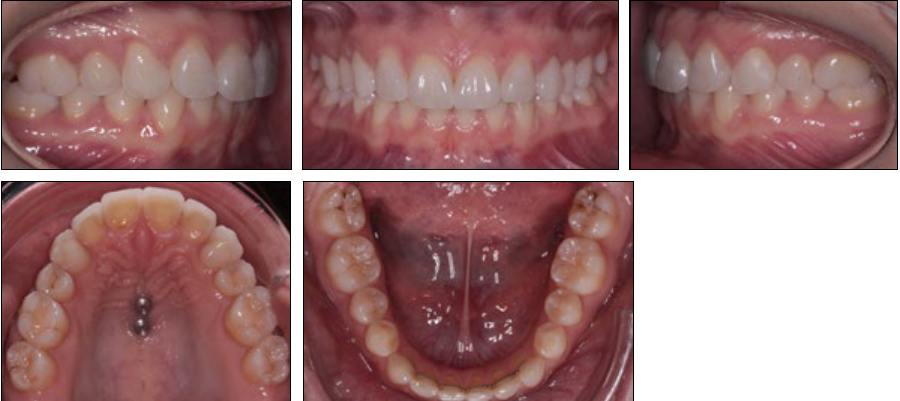
Figure 19. Intraoral photographs after two years of